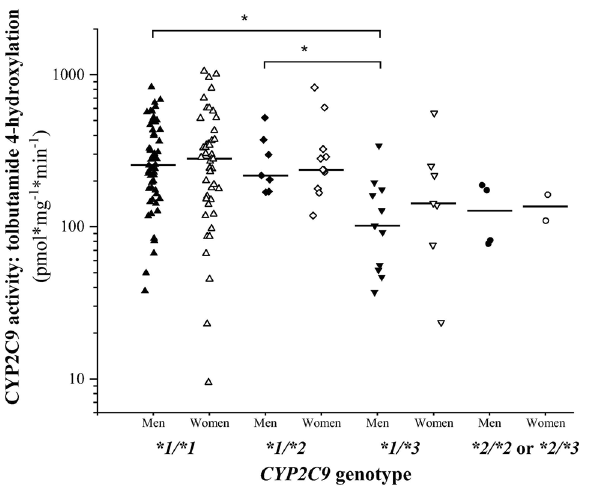
Figure 2. Gender-based differences in tolbutamide 4 ′ -hydroxylation between various CYP2C9 genotype groups. *Significant difference ( P < 0.05).